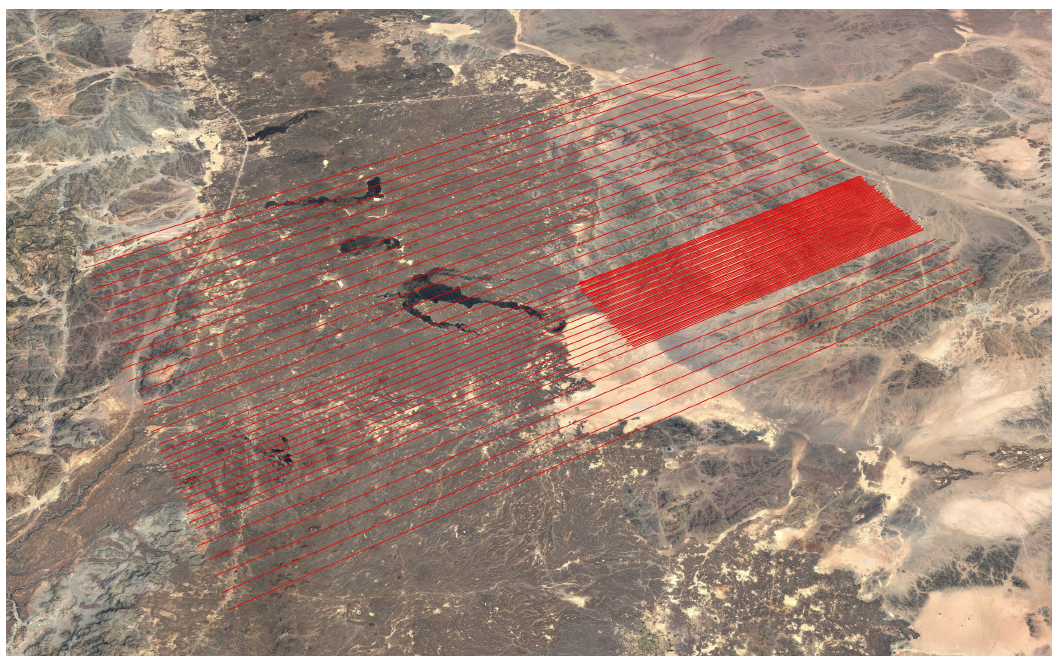
Figure 2. Perspective view of the survey